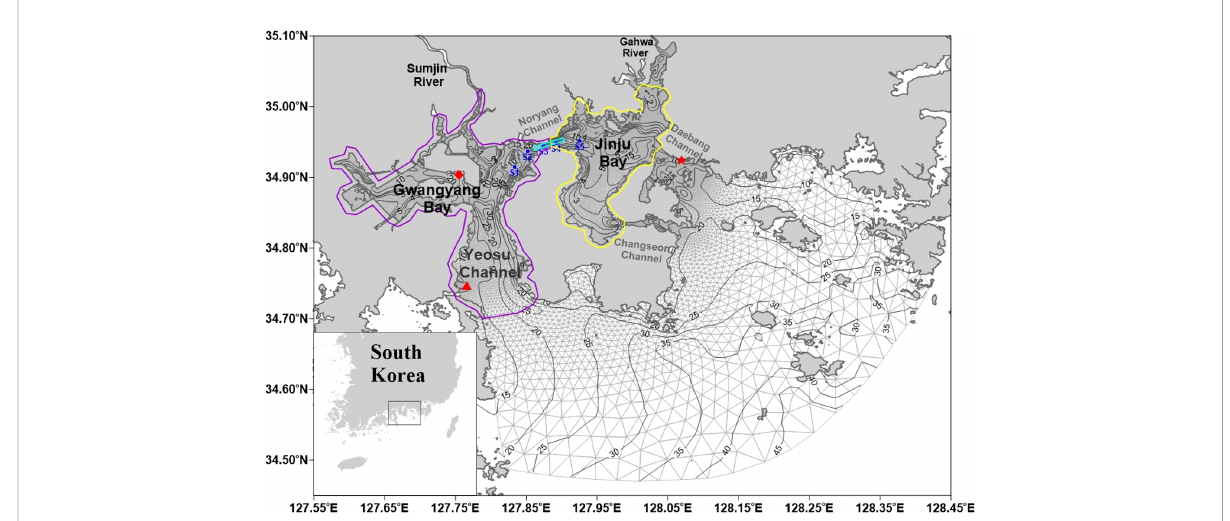
FIGURE 1 Study area, including Gwangyang and Jinju Bays. The red diamond, triangle, and star indicate the location of the tidal stations at Gwangyang, Yeosu, and Samcheonpo, respectively. The cyan rectangle denotes the location of the vertical pro fi les for the temperature, salinity, density, sea level, and density gradient. The blue circles represent CTD observation stations. The solid black lines indicate the water depth in meters. The gray triangles represent the model grid. The solid purple and yellow lines represent the initial concentration areas for dye experiment in Gwangyang and Jinju Bays,